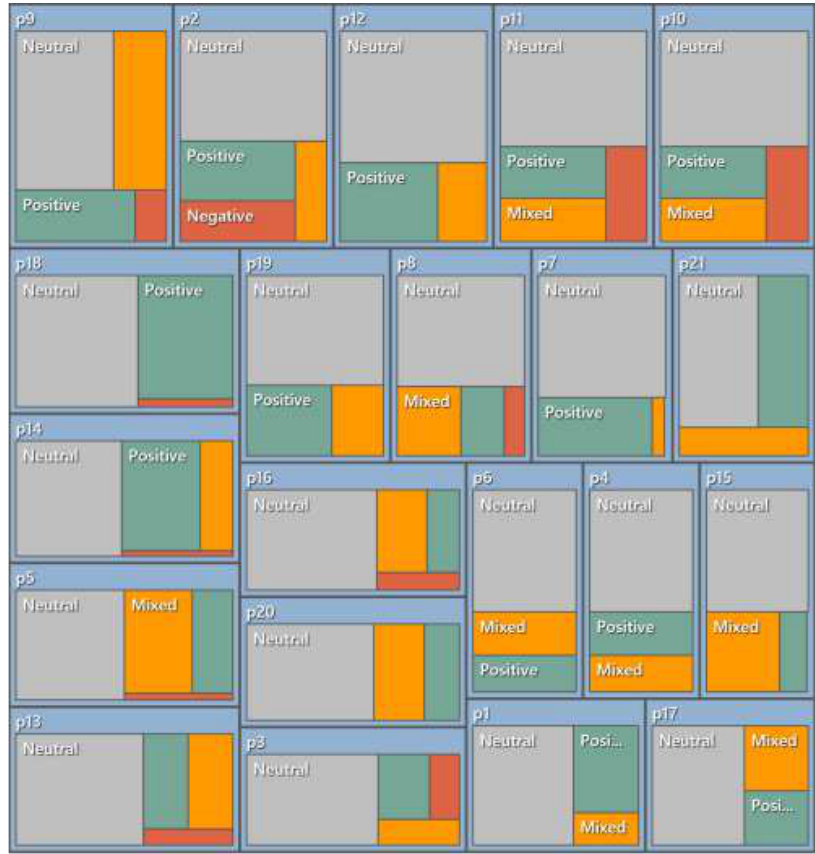
Figure 2. Hierarchy of students’ attitudes towards digitalization in